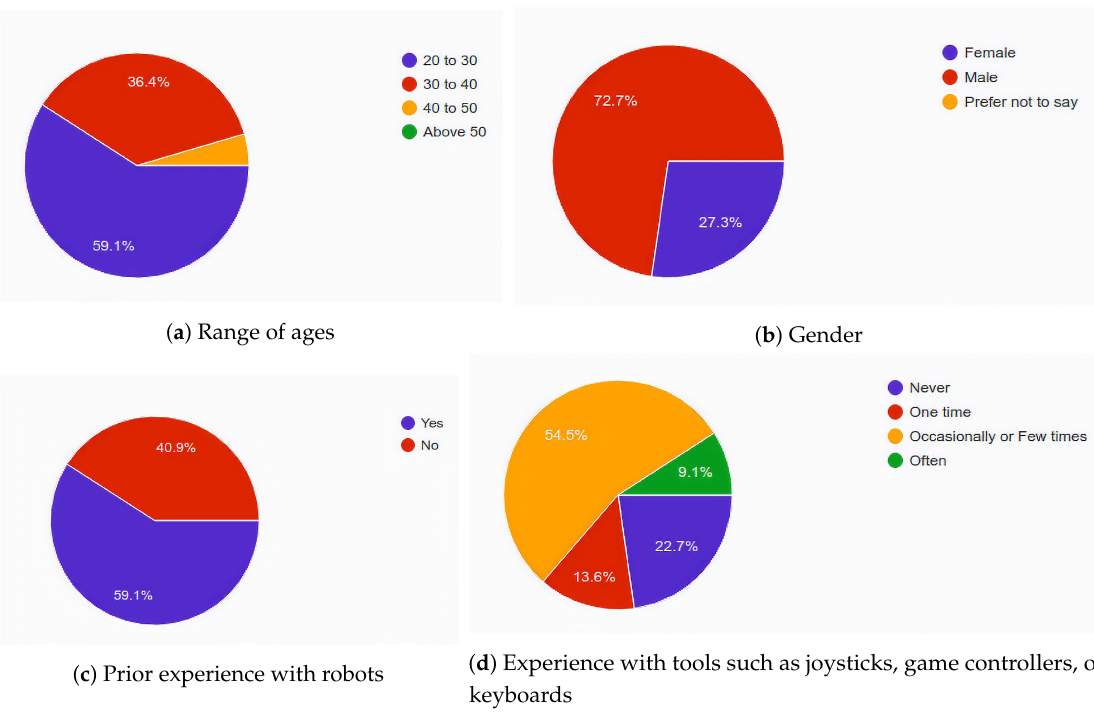
Figure 8. Information on subjects.